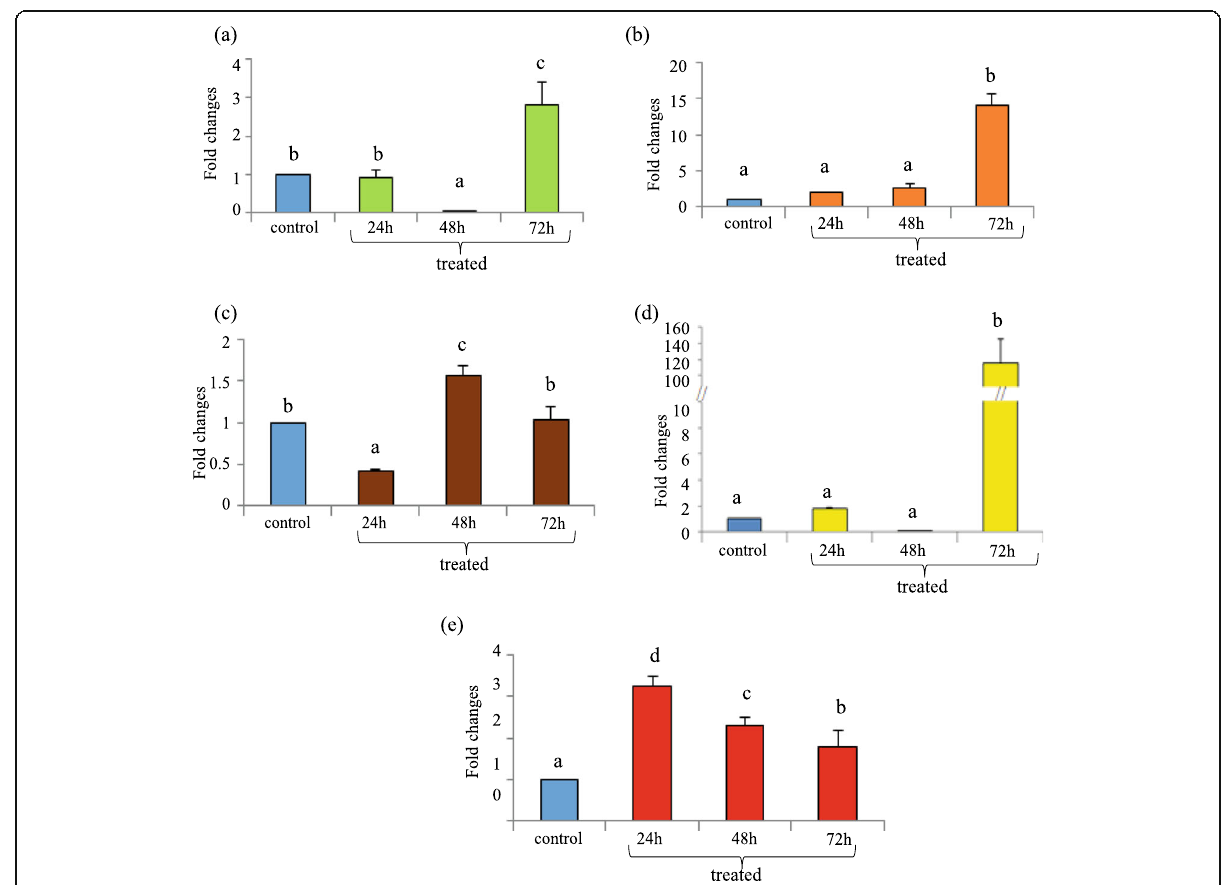
Fig. 8 Modulation of caspase-8 gene expression in rhabdovirus vaccination. Labeo rohita fingerlings ( n = 3) were inoculated with inactivated rhabdovirus vaccine by intra-peritoneal (i.p.) route. After the designated time course, total RNA was extracted from the gill, liver, kidney, spleen, and blood and quantitative real-time PCR was employed to analyze caspase-8 and β -actin gene expression in these tissues. Expression of caspase-8 gene in these tissues were normalized with β -actin and expressed as fold changes as compared to the un-infected control ( n = 3). The results are expressed as mean ± standard errors (bars). a Gill. b Liver. c Kidney. d Spleen. e